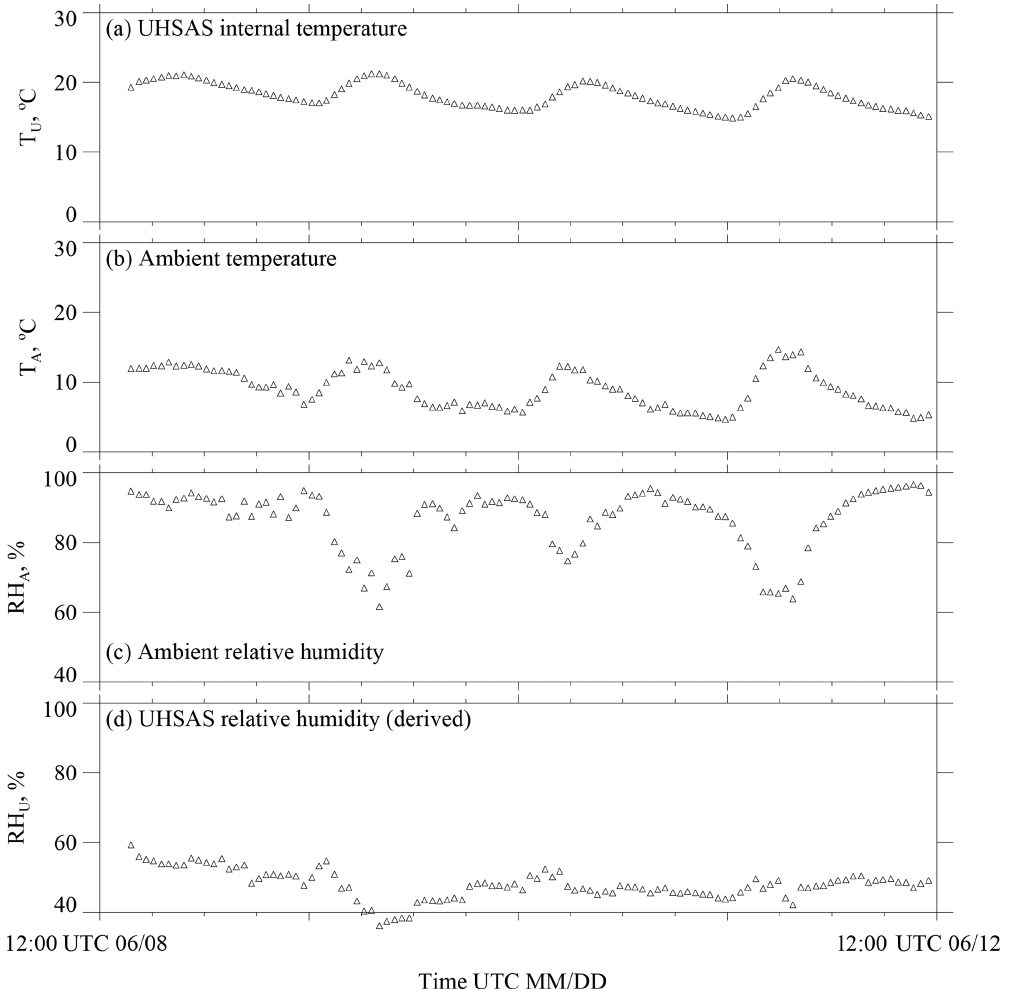
Figure A1. UHSAS internal temperature and ambient meteorological parameters at the Arauco site over a 4d period. (a) Temperature inside the UHSAS. (b) Temperature measured on the meteorological tower. (c) RH measured on the meteorological tower. (d) Derived RH inside